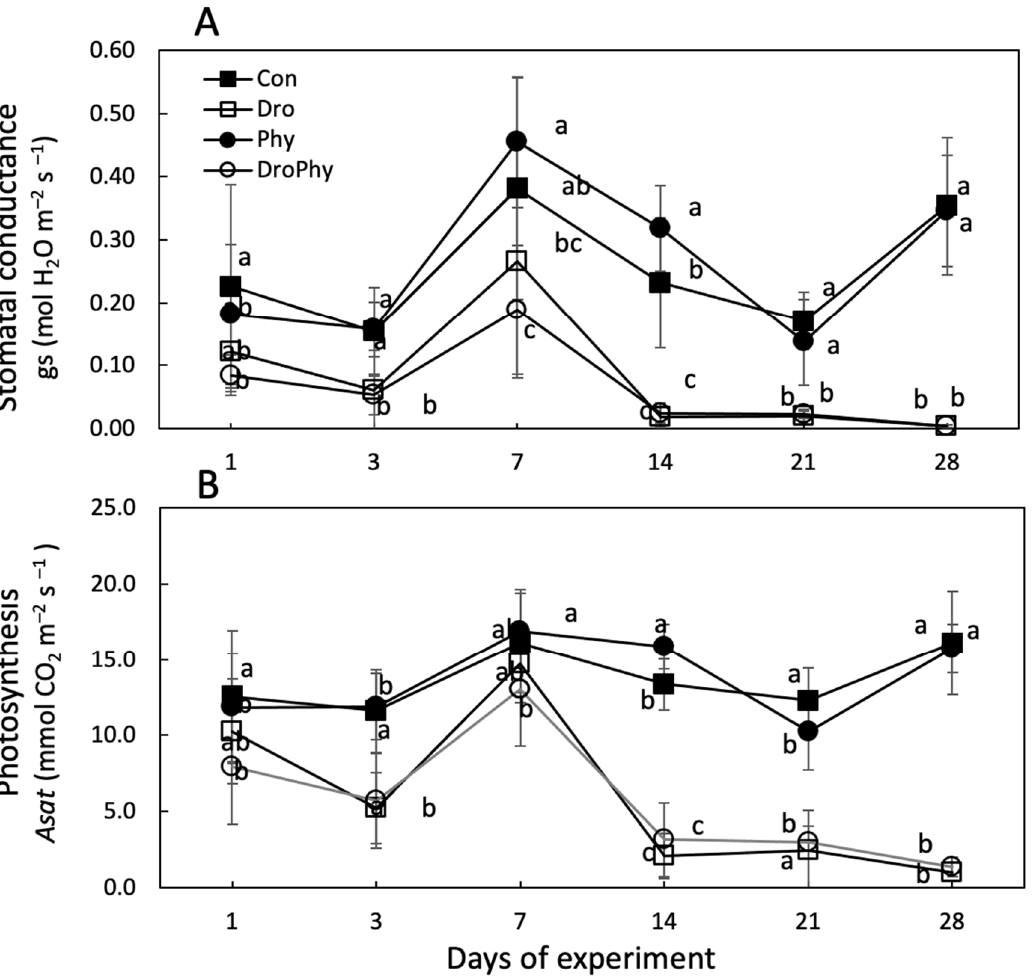
Figure 3. ( A ) Stomatal conductance (g s ) and ( B ) light-saturated photosynthesis rate (A sat ) of E. obliqua seedlings subjected to Control (Con), Drought (Dro), Phytophthora (Phy), and Drought- Phythophthora (DroPhy) after ANOVA and LSD test.